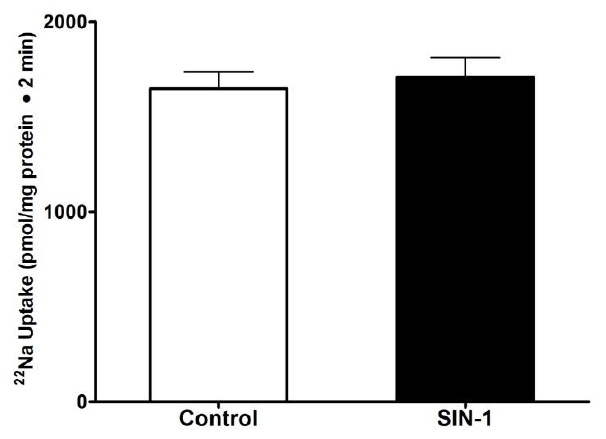
Figure 2. Effect of peroxynitrite on Na/H exchange (NHE3) in IEC-18 cells. A proton gradient-driven EIPA sensitive Na uptake was present in IEC-18 cells. Na-H exchange remained unaltered in the SIN-1 treated IEC-18 cells. n = 3.